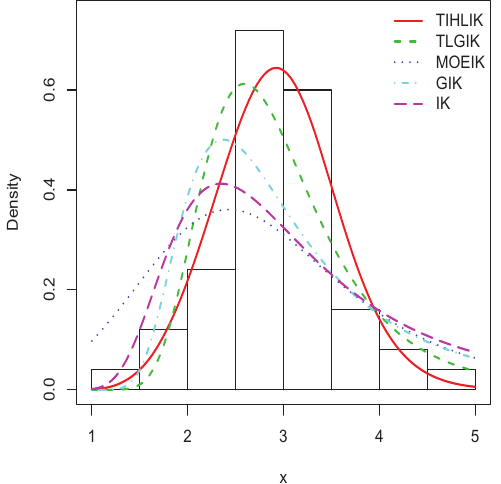
Figure 14. Plots of the estimated pdfs for data set